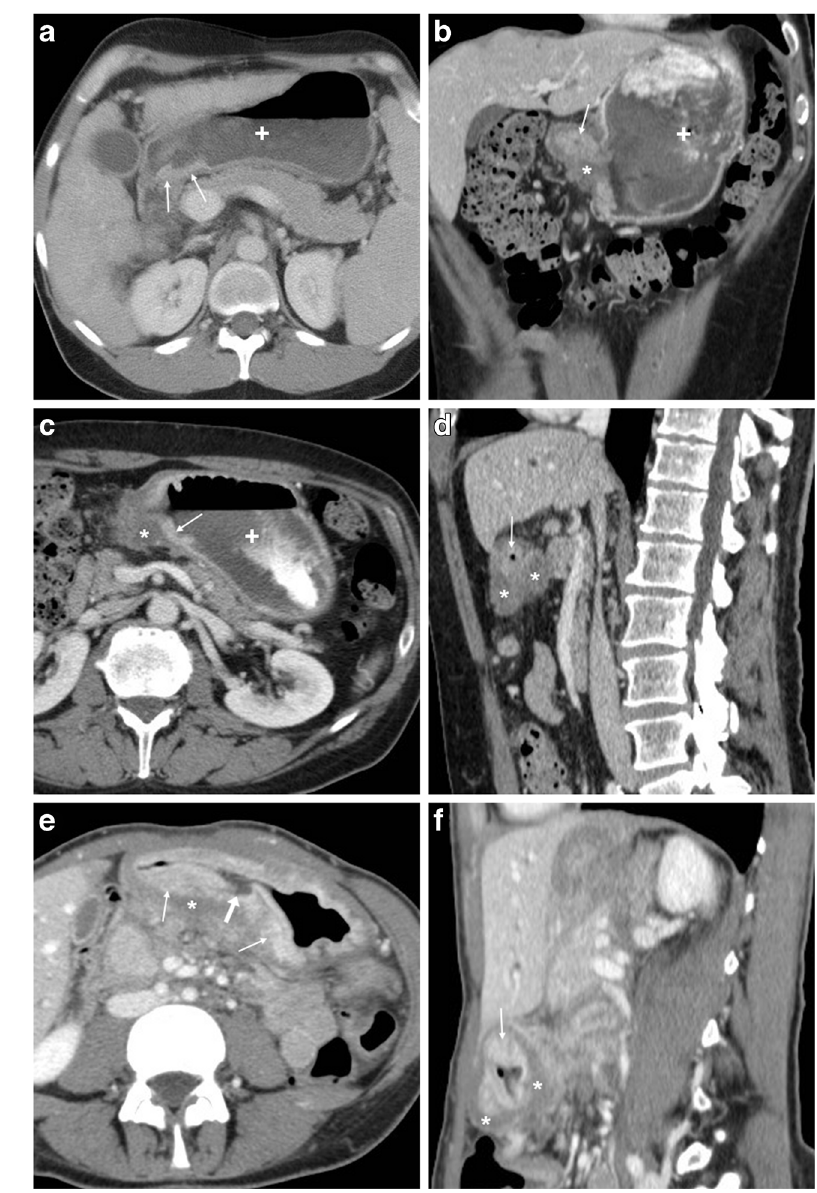
(*) with irregular, enhancing mucosal thickening (thin